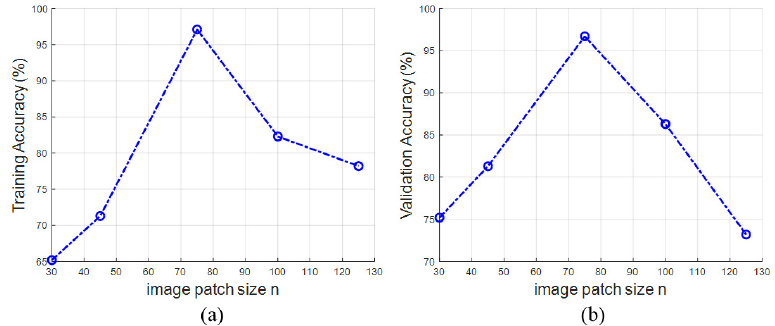
Figure 5. Training accuracy and cross-validation testing accuracy under different image patch sizes ( n = 30, 45, 75, 100, 125); ( a ) depicts the training accuracy, and ( b ) depicts the cross-validation